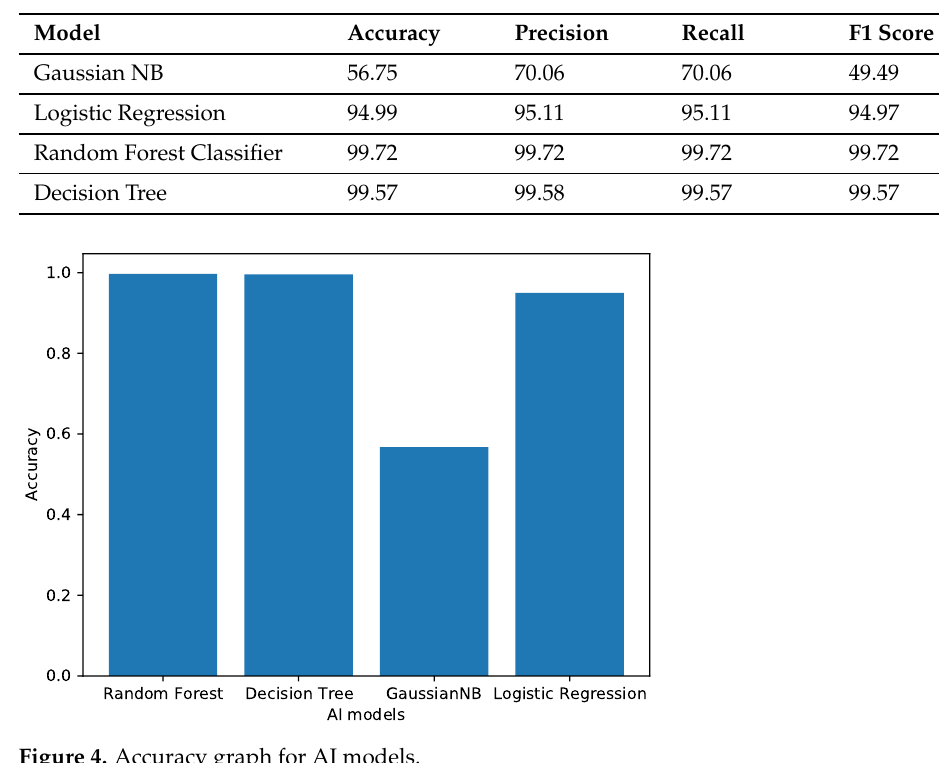
Table 3. Evaluation metrics of malicious user detection models.